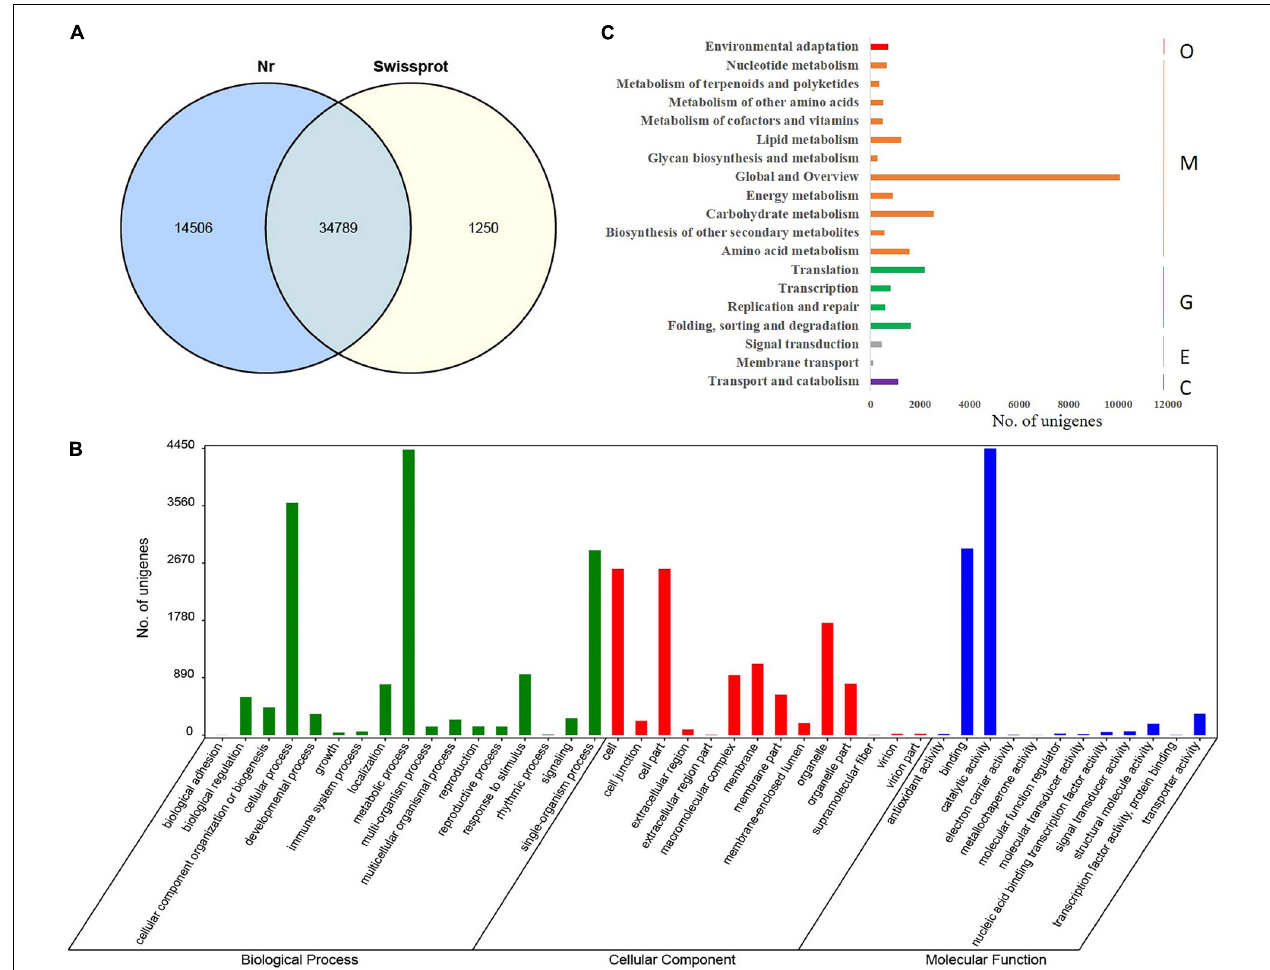
FIGURE 1 | Functional annotation and GO classification of assembled unigenes in C. camphora . (A) Functional annotation of assembled unigenes by BLASTx against Nr and Swissprot databases with an E -value threshold of 1e − 5 . A total of 34,789 unigenes were commonly annotated in the two databases. (B) GO terms of C. camphora unigenes determined by Blast2GO fell into the three categories of biological process, cellular component, and molecular function, where metabolic process, cell part, and catalytic activity were the three most prevalent subcategories, respectively. (C) KEGG classification of annotated unigenes. The x- axis shows the number of unigenes annotated, and the y axis shows the KEGG metabolic pathways the unigenes fell into, including organismal system (O), metabolism (M), genetic information processing (G), environmental information processing (E), and cellular processes (C).